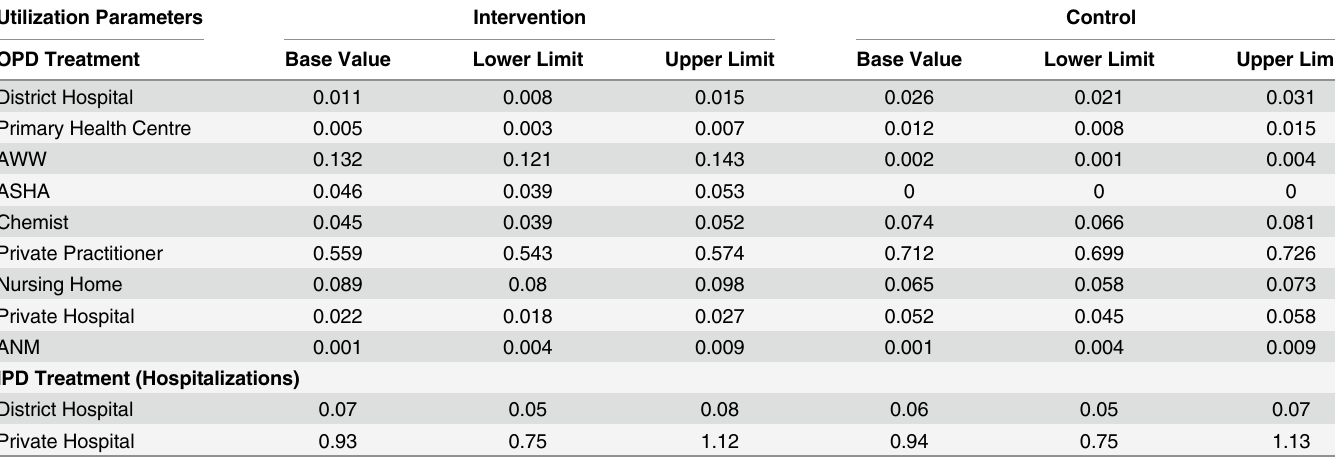
Table 2. Treatment Seeking Behaviour Parameters for IMNCI Cost Effectiveness Decision